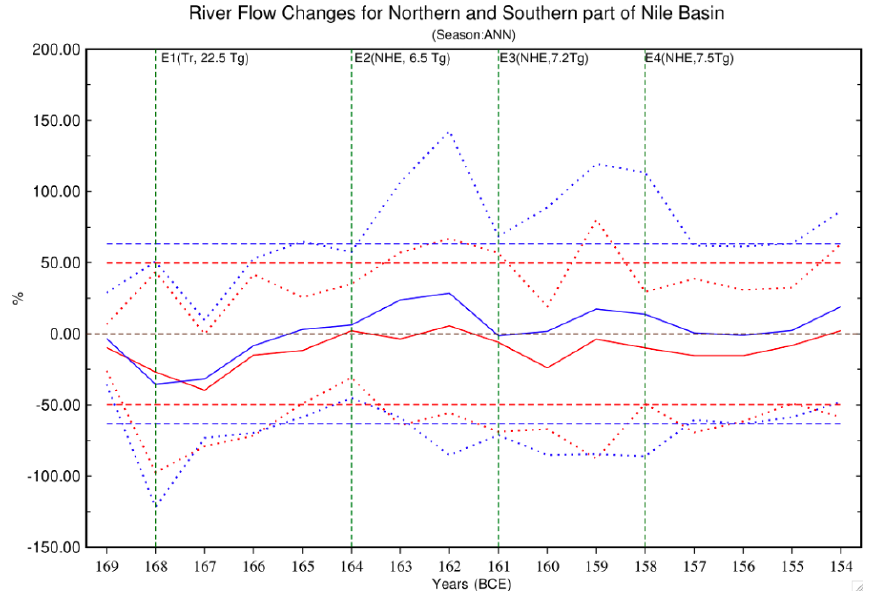
Figure 13. Annual Nile River flow changes averaged over the northern (red) and southern (blue) parts of the basin (divided at 10 ◦ N) for the entire simulation period. The solid lines represent the ensemble mean for each part of the basin; the dotted lines are ± 1 . 95 σ , where σ is derived from across all the ensembles, and the horizontal dashed lines parallel to x axis are the ± 1 . 95 σ ctrl , where σ ctrl is the standard deviation across the 100-year control run. Red and blue lines correspond to the northern and southern parts of the Nile basin, respectively.